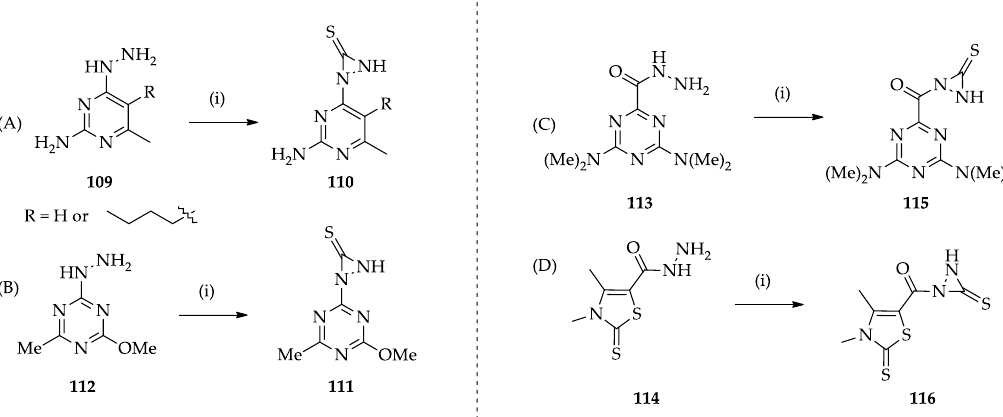
Figure 15. Synthesis of N -monosubstituted diaziridines 110 , 111 , 115 , and 116 via the unconventional method by elaborating hydrazine, CS 2 , and KOH. ( A ) pyrimidine, ( B ) 1,3,5-triazine, ( C ) carbonylated 1,3,5-triazine and ( D ) carbonylated thiazole-2(3 H )-thione. Reagents: (i) CS 2 , KOH, ethanol.